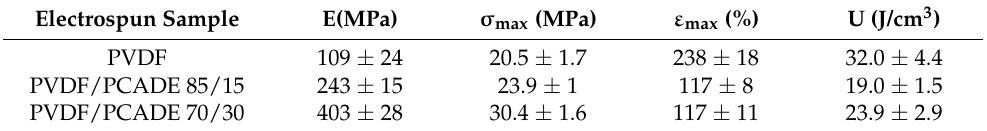
Figure 4. ( a ) Representative stress − strain curves of PVDF (black), PVDF/PCADE 85/15 (blue) and PVDF/PCADE 70/30 (red); ( b ) Elastic modulus and maximum stress as a function of PCADE weight content. Table 2. Elastic modulus (E), maximum stress (σ max ), maximum deformation (ε max ) and absorbed strain energy (U) of the electrospun samples determined by stress−strain tests.